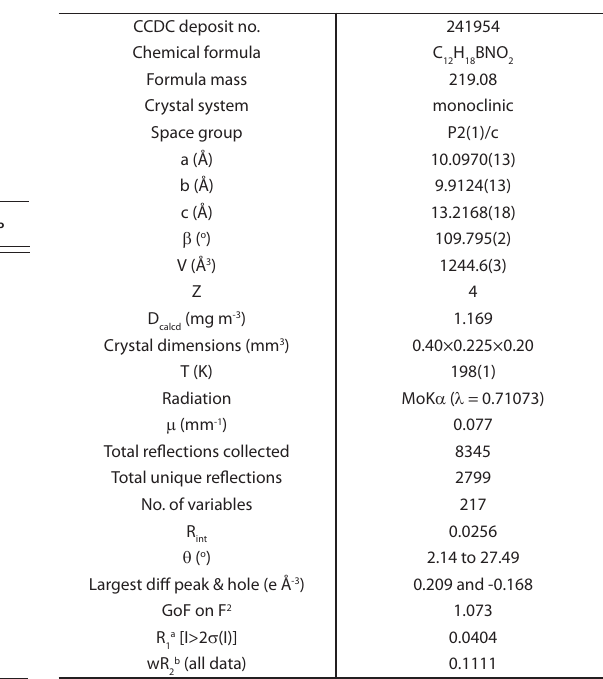
Table 2. Crystallographic data collection parameters for